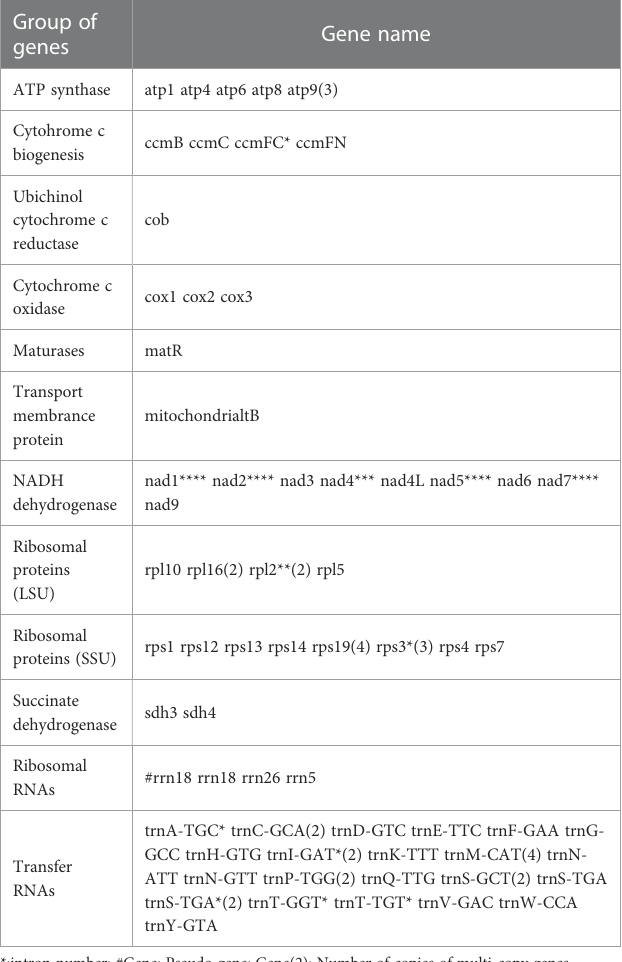
TABLE 1 Gene pro fi le and organization of the C.duntsa mitochondrial genome. Group of genes